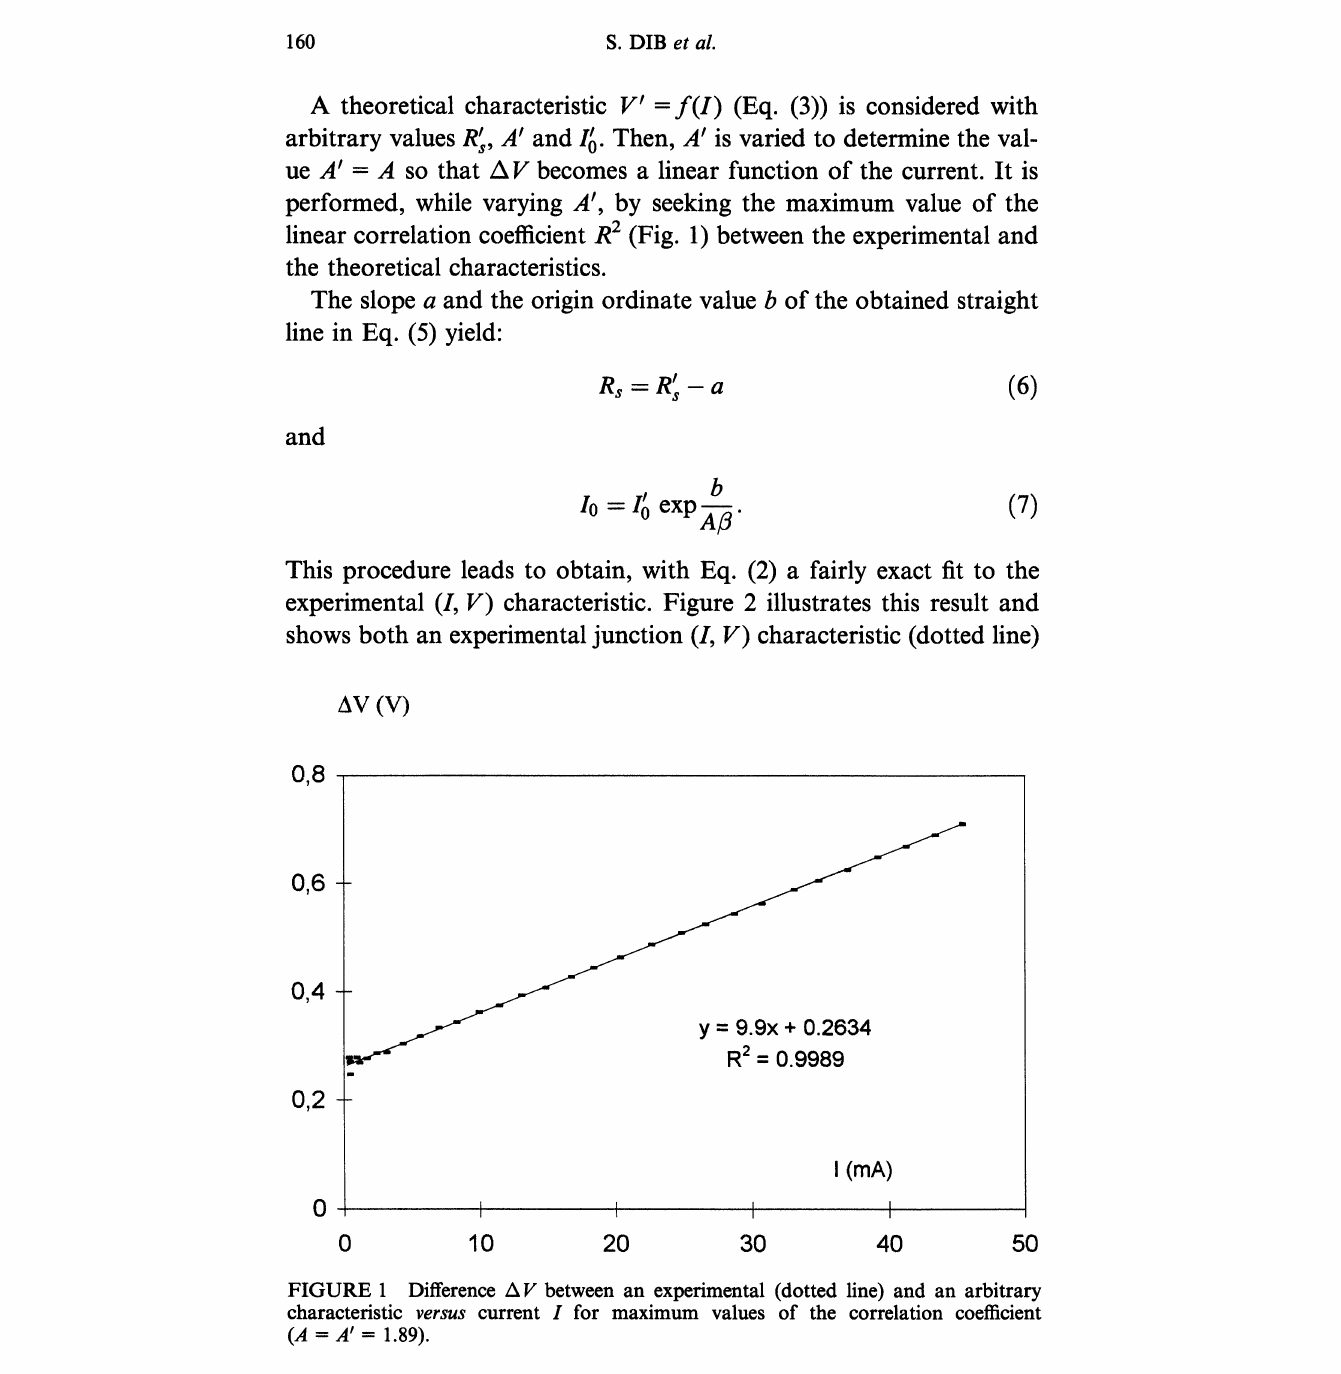
Difference A V between an experimental (dotted line) and an arbitrary characteristic versus current 1 for maximum values of the correlation coefficient (A A t=